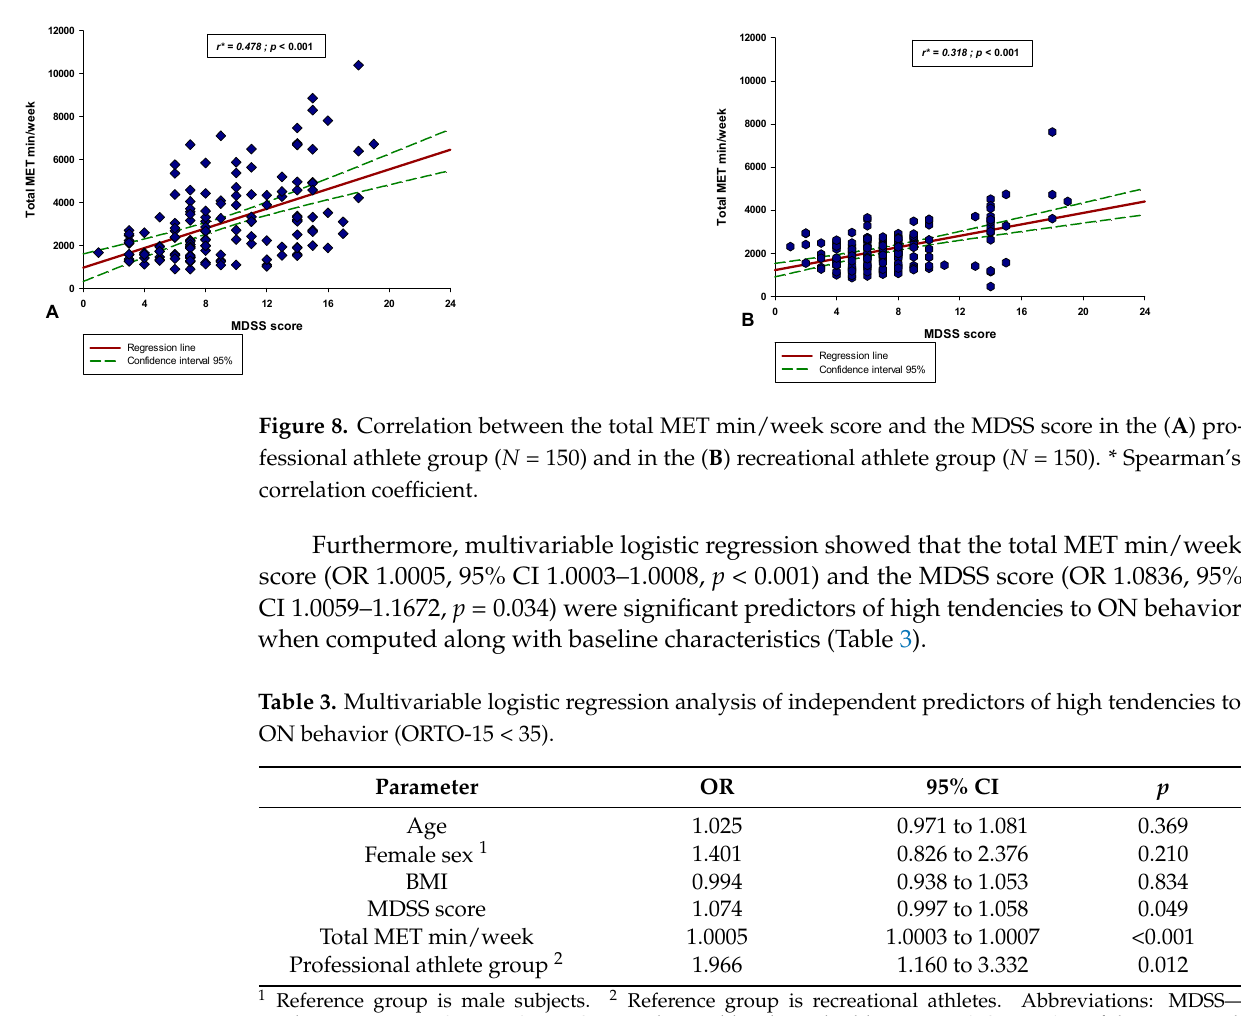
Table 3. Multivariable logistic regression analysis of independent predictors of high tendencies to ON behavior (ORTO-15 < 35).